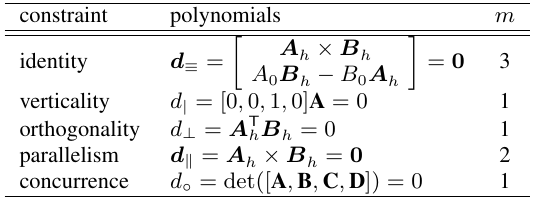
Table 1: Potential geometric relations between planes A , B , C and D expressed by multivariate polynomials and the number of independent equations (degrees of freedom m ).